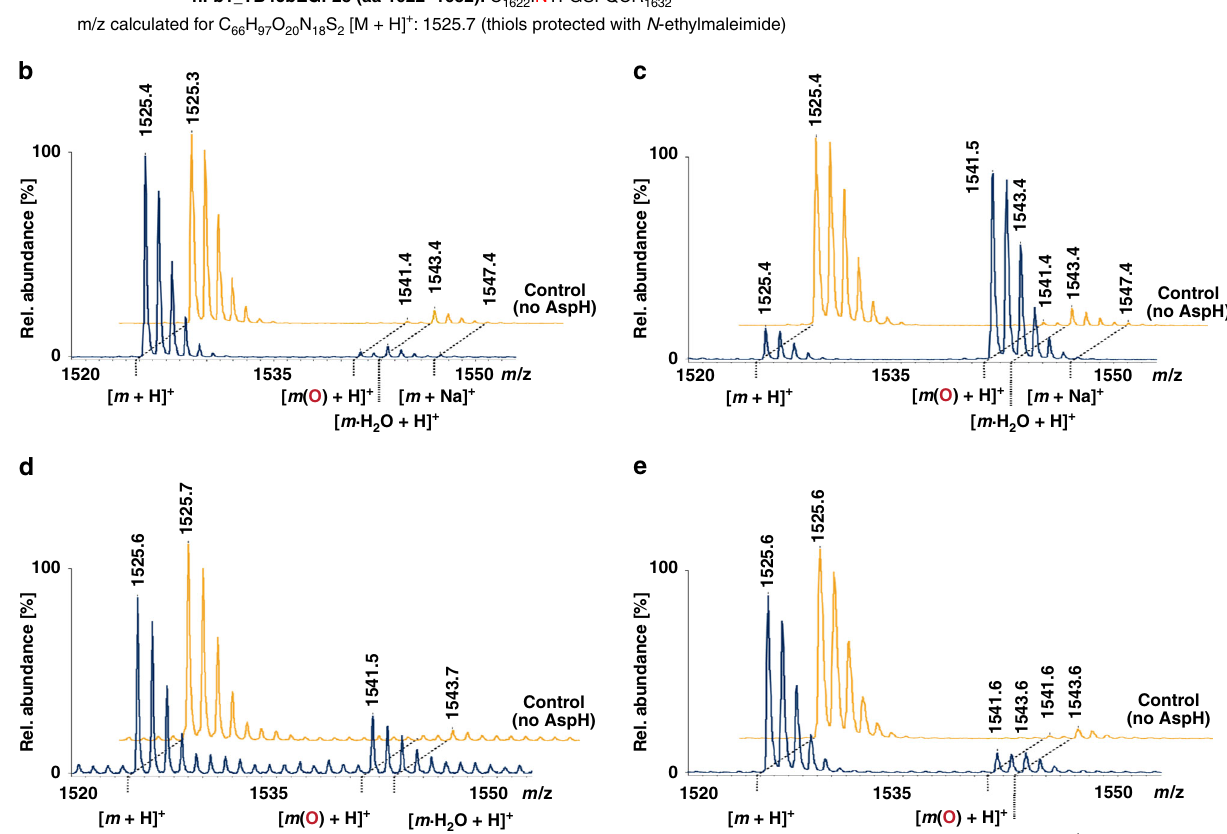
Fig. 9 Ca(II) ions inhibit AspH-catalysed hydroxylation of a human fi brillin-1 fragment. End-point turnover reactions were performed with an incubation time of 180 min (See Methods Section). Prior to analysis, the substrate was reduced and cysteine thiols were derivatized with N -ethylmaleimide, then digested using trypsin, and analysed using MALDI-ToF-MS. Light orange graphs represent controls in which AspH was replaced by buffer. a Sequence of the fragment of human fi brillin-1, TB4cbEGF23 (hFIB1_TB4cbEGF23, aa 1527 – 1647; Uniprot Database entry: FBN1_HUMAN), bearing the hydroxylation site (Asn1624 hFIB1 , red). b <5% Hydroxylation was observed under standard (non-redox) conditions. c ~85% Hydroxylation was observed under redox conditions. d ~25% Hydroxylation was observed under redox conditions in the presence of 1 mM Ca(II). e ~10% Hydroxylation was observed under redox conditions in the presence of 3 mM